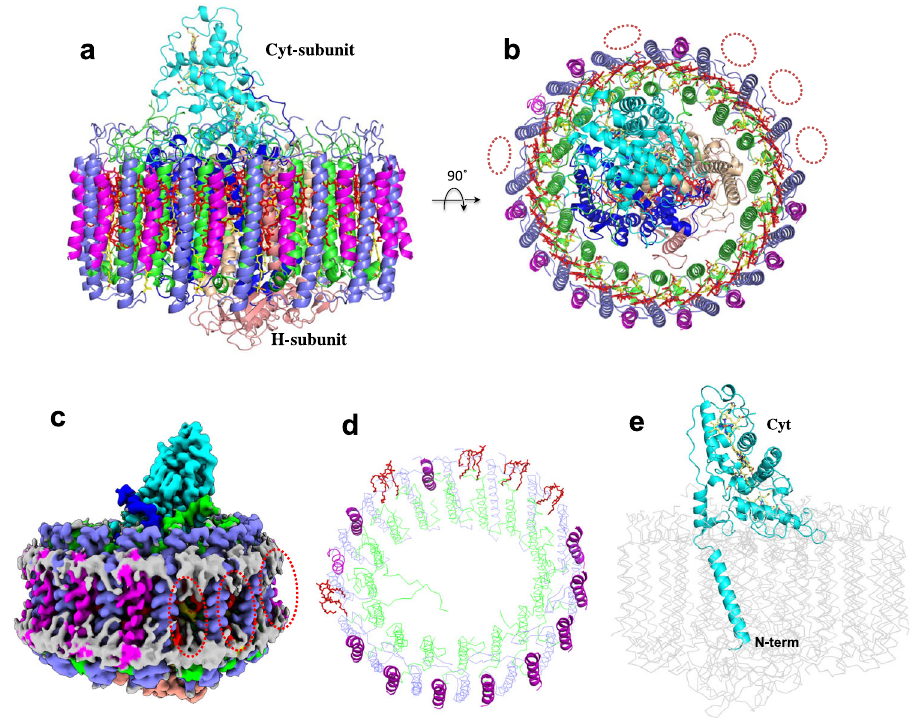
Fig. 1 Structure overview of the LH1 – RC core complex from Rpi. globiformis . a Side view of the core complex parallel to the membrane plane. b Top view from the periplasmic side of the membrane. Dotted ovals indicate the positions that lack the γ -like polypeptide. c Side view of surface representation of the complex. Dotted red ovals indicate the positions that lack the γ -like polypeptide. d Tilted view showing distributions of the γ -like polypeptides (magenta cartoons) and cardiolipins (red sticks) in the LH1 ring. e Side view of the Cyt subunit (cyan) in the LH1 – RC showing its N-terminal transmembrane domain. Heme groups are shown by paleyellow sticks. Color scheme: LH1- α , green; LH1- β , slate blue; LH1- γ , magenta; RC-C, cyan; RC-L, wheat; RC-M, blue; BChl a , red sticks; carotenoids, yellow sticks; BPhe a , magenta sticks; lipids or detergents,